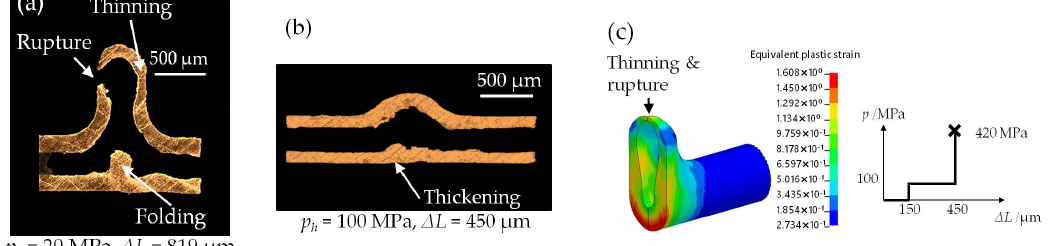
Figure 21. Typical failure modes that occur in the T ‐ shape MTHF process observed in experiments and FE simulation (C1220): ( a ) folding, thinning and rupture; ( b ) thickening; ( c ) rupture at crown.